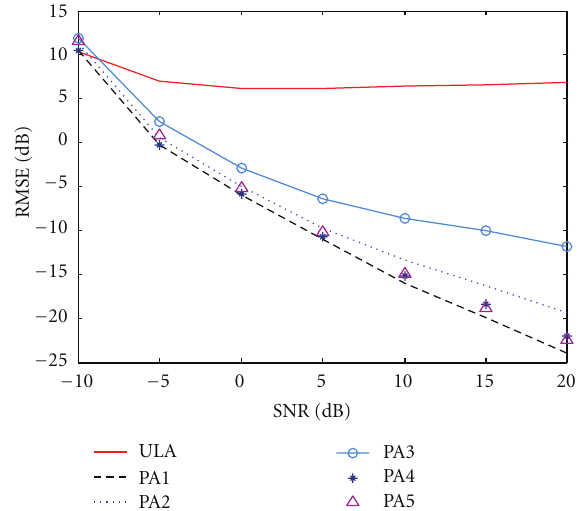
Figure 9: Total RMSE of the MVDR algorithm for di ff erent configurations where signals are arriving at boresight and endfire directions.